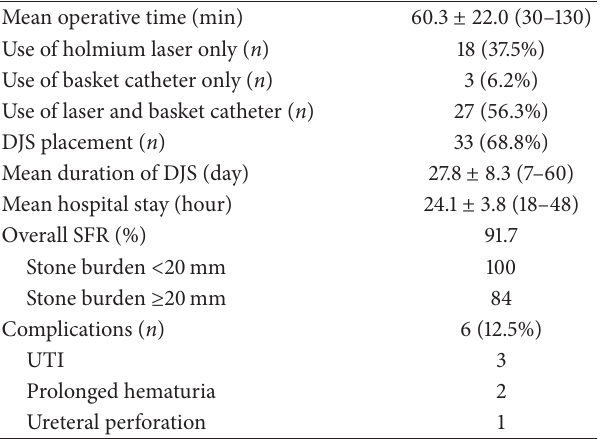
Table 1: Preoperative stone demographics. Table 2: Evaluation of intraoperative and postoperative